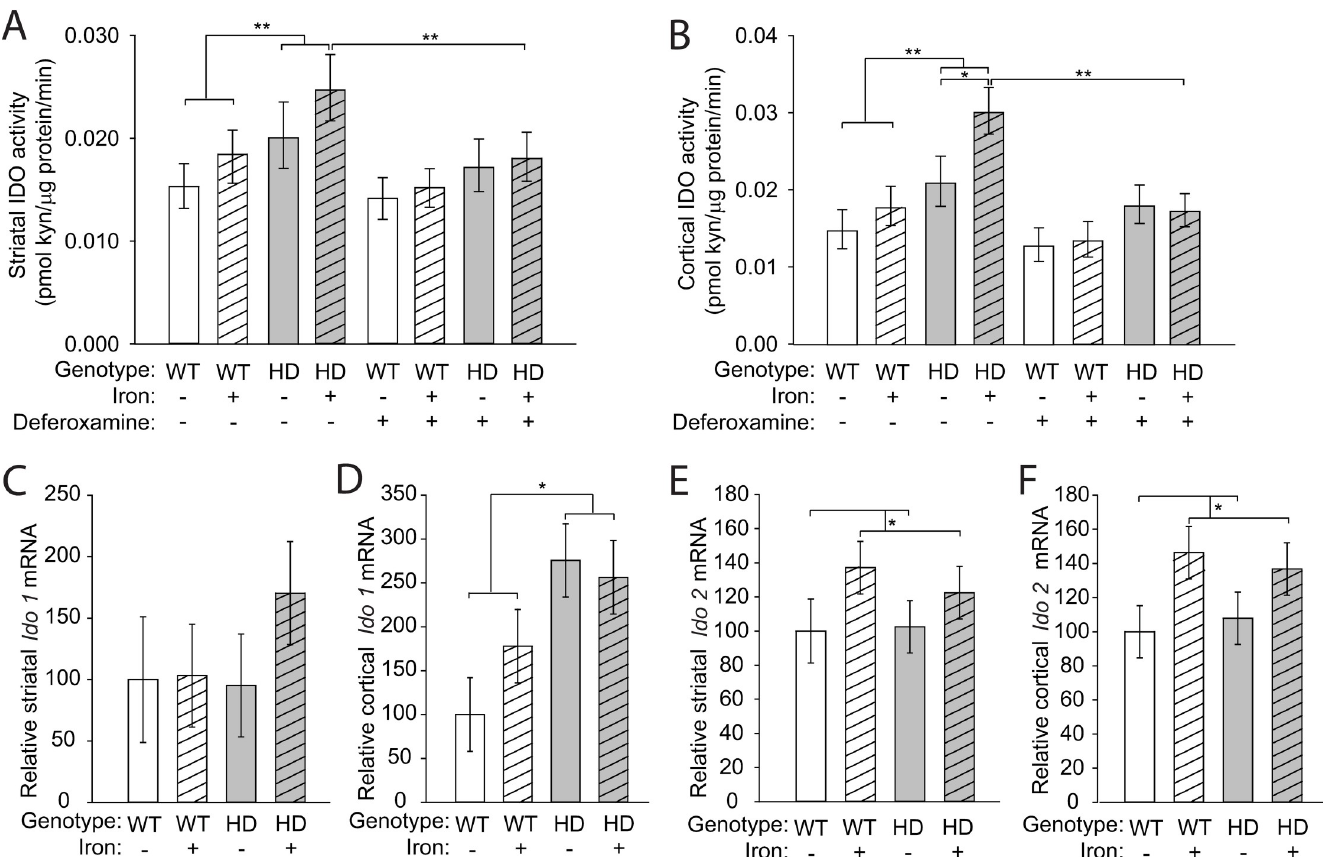
Fig 1. Elevated IDO activity in HD mouse brains is decreased by ex-vivo iron chelation. Mouse pups were supplemented with carbonyl iron from postnatal days 10– 17 and then were sacrificed at 14 weeks of age. A. Striatal IDO activity is increased in N171-82Q HD mice and significantly decreased by ex vivo iron (III) chelation (50 μ M deferoxamine). B. Cortical IDO activity is increased in iron-supplemented HD mice compared to non-supplemented HD mice and activity is decreased by ex vivo iron chelation. C . There is no difference in relative transcript levels of IDO1 in striatum. D. IDO1 mRNA is increased in cortex of HD mice at 14-weeks of age. E, F . Iron increases levels of IDO2 in striatum ( E ) and cortex ( F ) but there was no significant effect of HD on IDO2 mRNA. A, B . Bars represent means ± 95% CI. n = 9 wild-type and 11 HD mice in each group. � p < 0.05, �� p < 0.01. C, F . Bars represent means ± SE, n = 6; � p < 0.05.